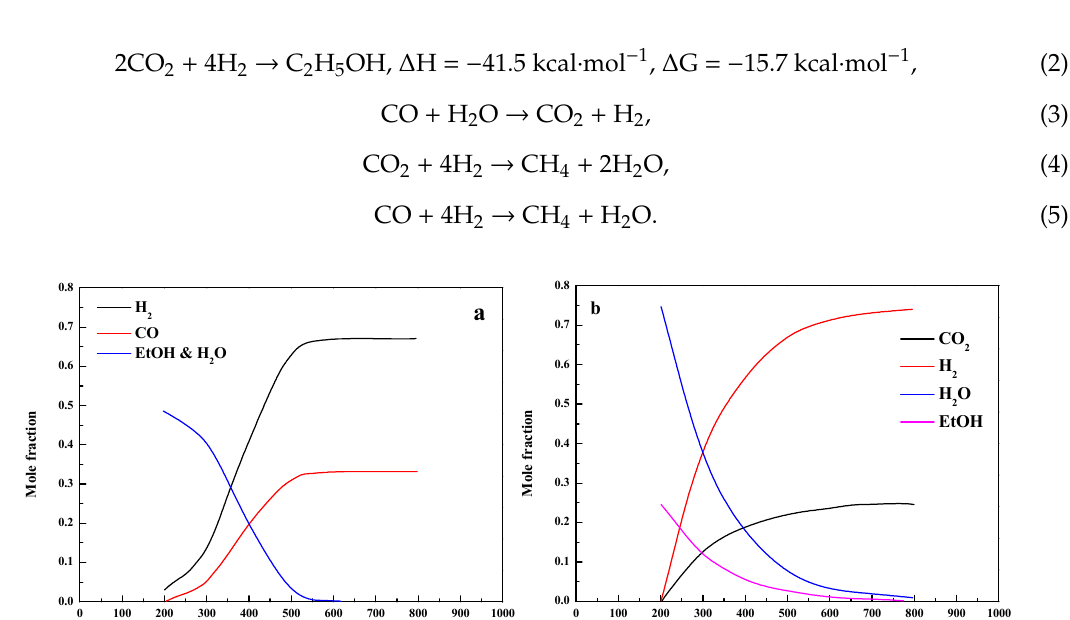
Figure 3. Thermodynamic analysis of the hydrogenation of CO ( a ) and CO 2 ( b ; H 2 /CO = 2.0, H 2 /CO 2 = 3.0, 30 bar).